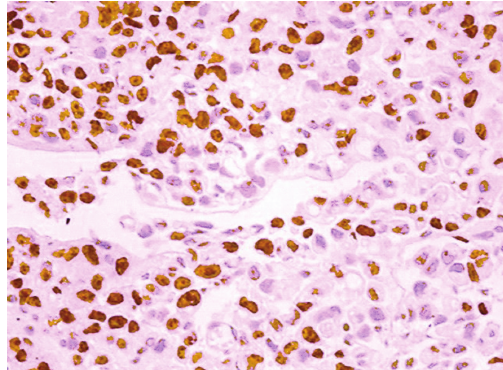
Figure 4: Example of immunohistochemical staining for Ki-67 antigen in esophageal adenocarcinoma under 200x microscopic magnification (stained cells are marked with an